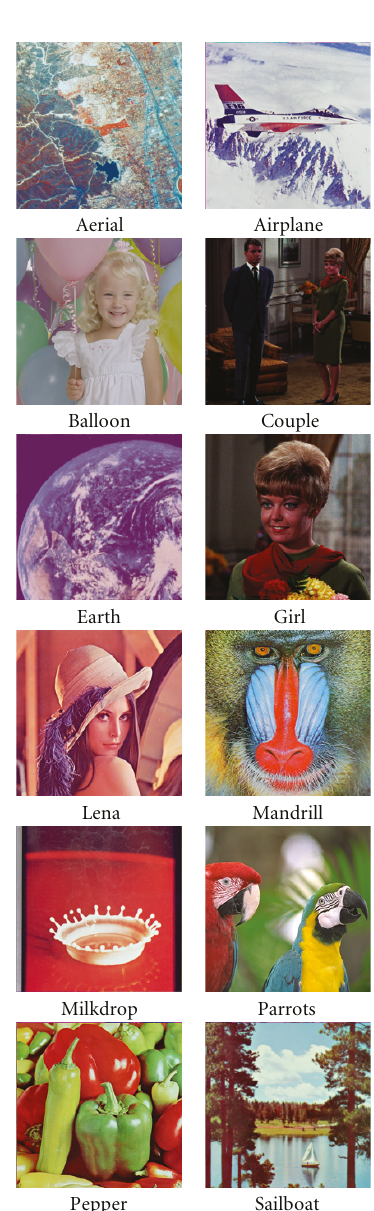
Figure 6: Original